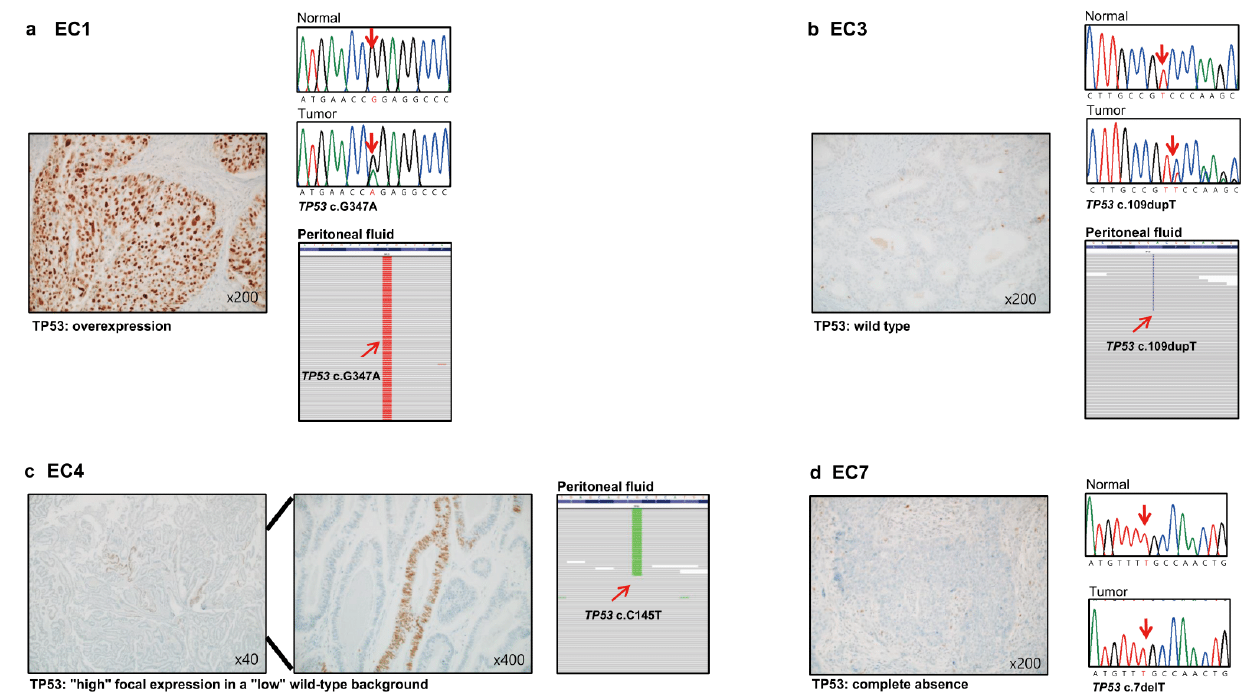
Figure 3. P53 immunohistochemical staining (left) and corresponding TP53 mutations using sanger sequencing (tumor tissues) and whole-exome sequencing snapshot (peritoneal fluid) (right) (tissues; EC1, EC3, and EC7, peritoneal fluid; EC1, EC3, and EC4). ( a ) Left: cancer cells show diffuse strong nuclear staining in almost every nucleus. Right: validation of TP53 mutation using Sanger sequencing of tissues and whole-exome sequencing snapshot from the peritoneal fluid (EC1). ( b ) Left: the tumor cells show wild type pattern. Right: validation of TP53 mutation using Sanger sequencing of the tissue sample and whole-exome sequencing snapshot of the peritoneal fluid sample (EC7). ( c ) Left: tumor cells show a wild type pattern with a “high” focal expression in a “low” wild type background. Right: whole-exome sequencing snapshot of the peritoneal fluid sample (EC4). ( d ) Left: tumor cells are completely negative in all tumor cell nuclei. Right: validation of TP53 mutation using Sanger sequencing of the tissue sample.